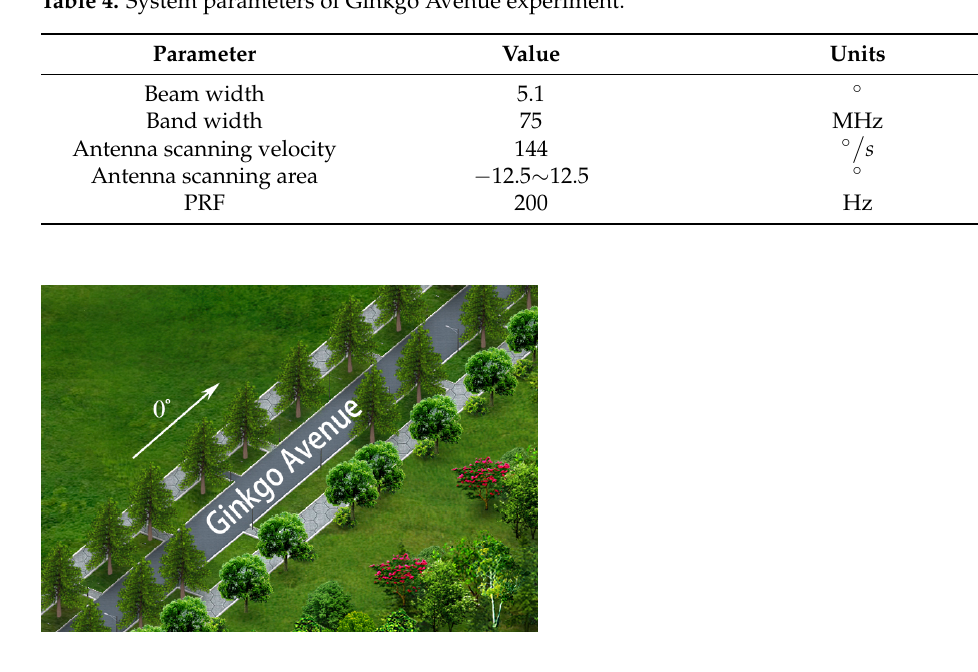
Figure 6. Optical scene of Ginkgo Avenue